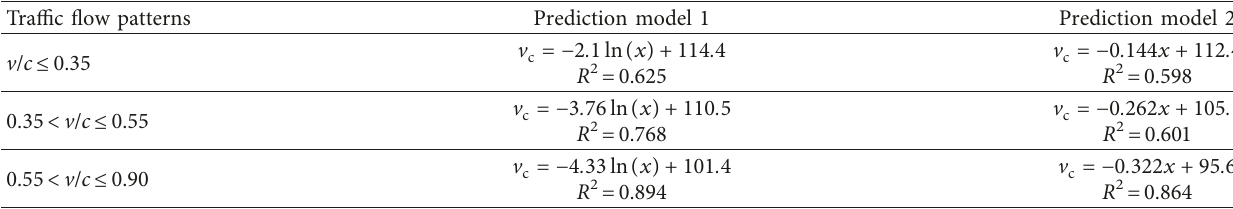
Table 4: Passenger-car speed prediction model for the mixing rate of large vehicles.